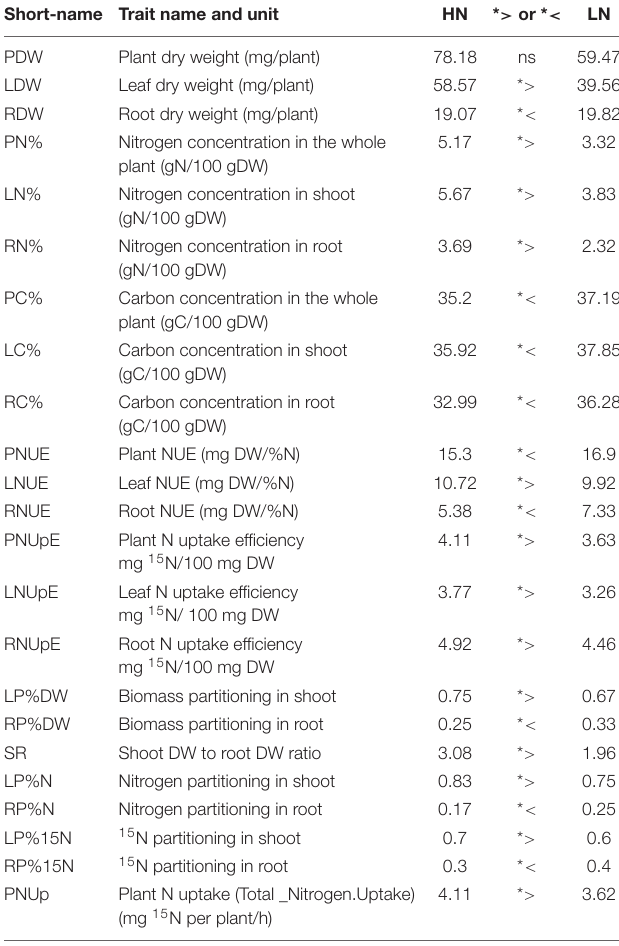
TABLE 2 | Comparison of global trends of physiological traits within the barley collection under HN and LN. Short-name Trait name and